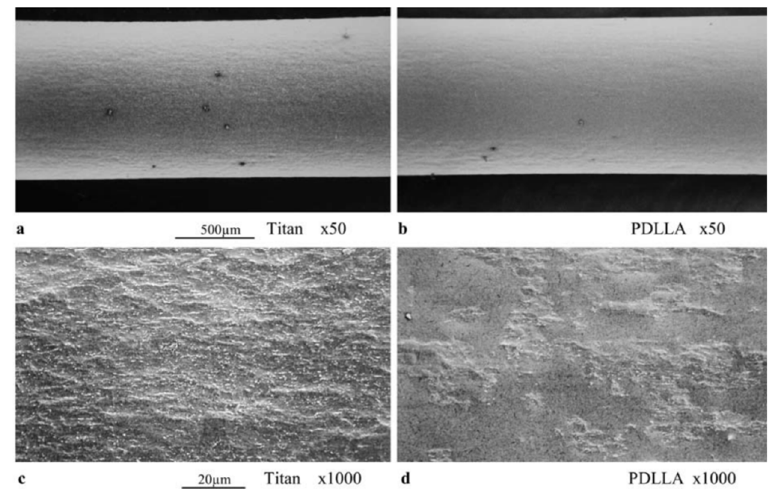
Figure 10. Comparing electron microscopic images of Titanium implants (surface modification) ( a ) without PDLLA at 50×, ( b ) with PDLLA at 50×, ( c ) without PDLLA at 1000×, and ( d ) with PDLLA at 1000× [50] . Reprinted with permission from ref. [50] . © 2021 Springer Nature.